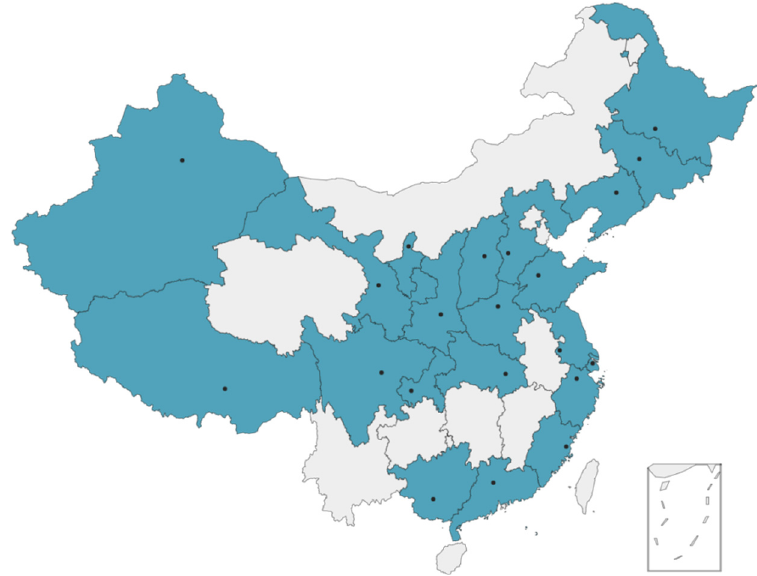
Figure 1. The geographical distribution of vantage points.